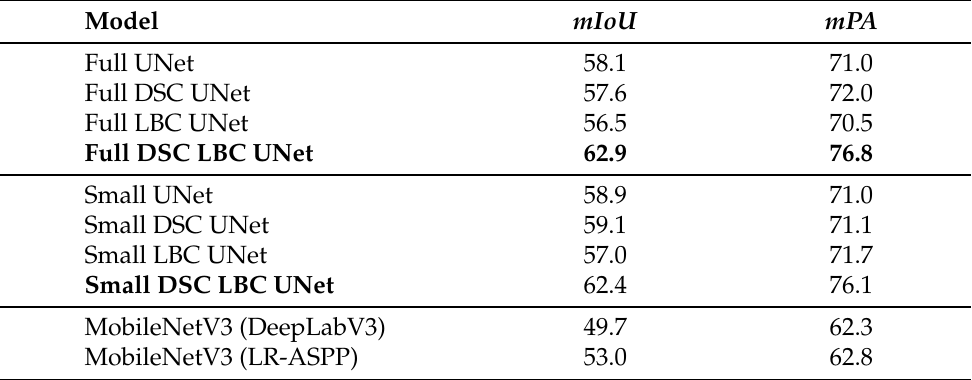
Figure 7. mIoU results for a Full UNet, Small DSC LBC UNet, and MobileNetV3 (LR-ASPP) for varying numbers of images with snow in the training and test sets. Training sets had either 0/30, 10/30, 20/30, or 30/30 of the images containing snow, while the test set had either 0/10 ( a ), 5/10 ( b ), or 10/10 ( c ) of the images containing snow. Three instances of each model were trained under each scenario and their mean value was used with the standard deviation shown by the error bar. Table 2. mIoU and mPA scores on the test set corrupted with snow noise. Models were trained on the training set without snow noise. Numbers in bold highlight the best scores while the Small DSC LBC UNet is in bold as it is the model of